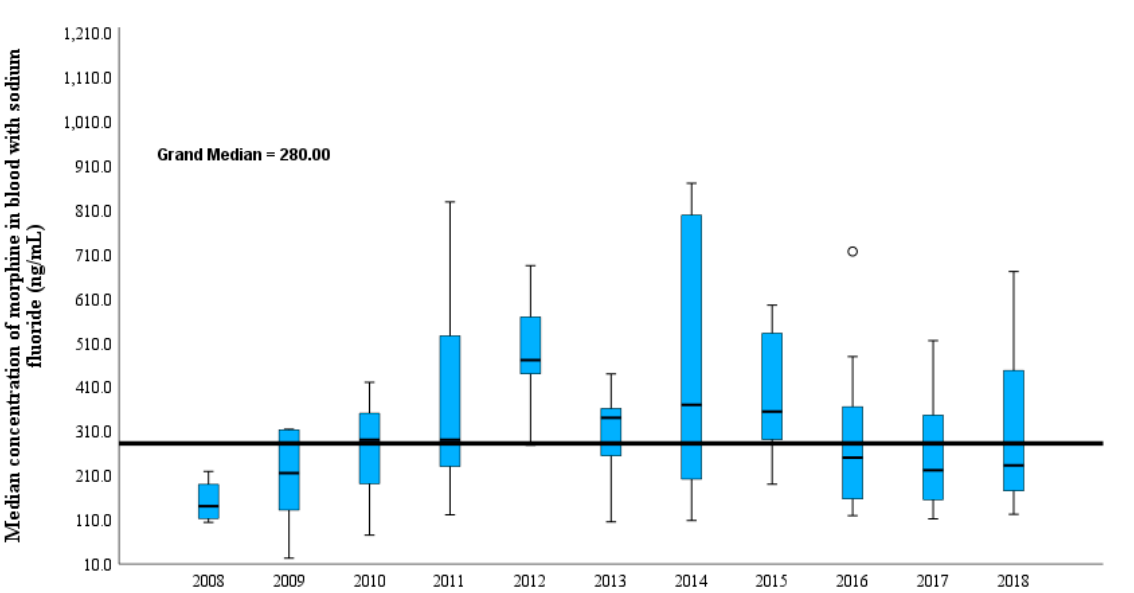
Figure 2. Variation in median concentration of morphine in blood with sodium fluoride in heroin- related deaths cases over a 10-year period. The horizontal boxes correspond to the median concen- tration ratio, and the box lengths correspond to the 25–75th percentile. The whiskers correspond to the smallest and largest value within 1.5 times the interquartile range, and circles (outlier) symbolize values exceeding at least 1.5 times the interquartile range and extremes (asterisks) correspond to values exceeding at least 3.0 times the interquartile range.